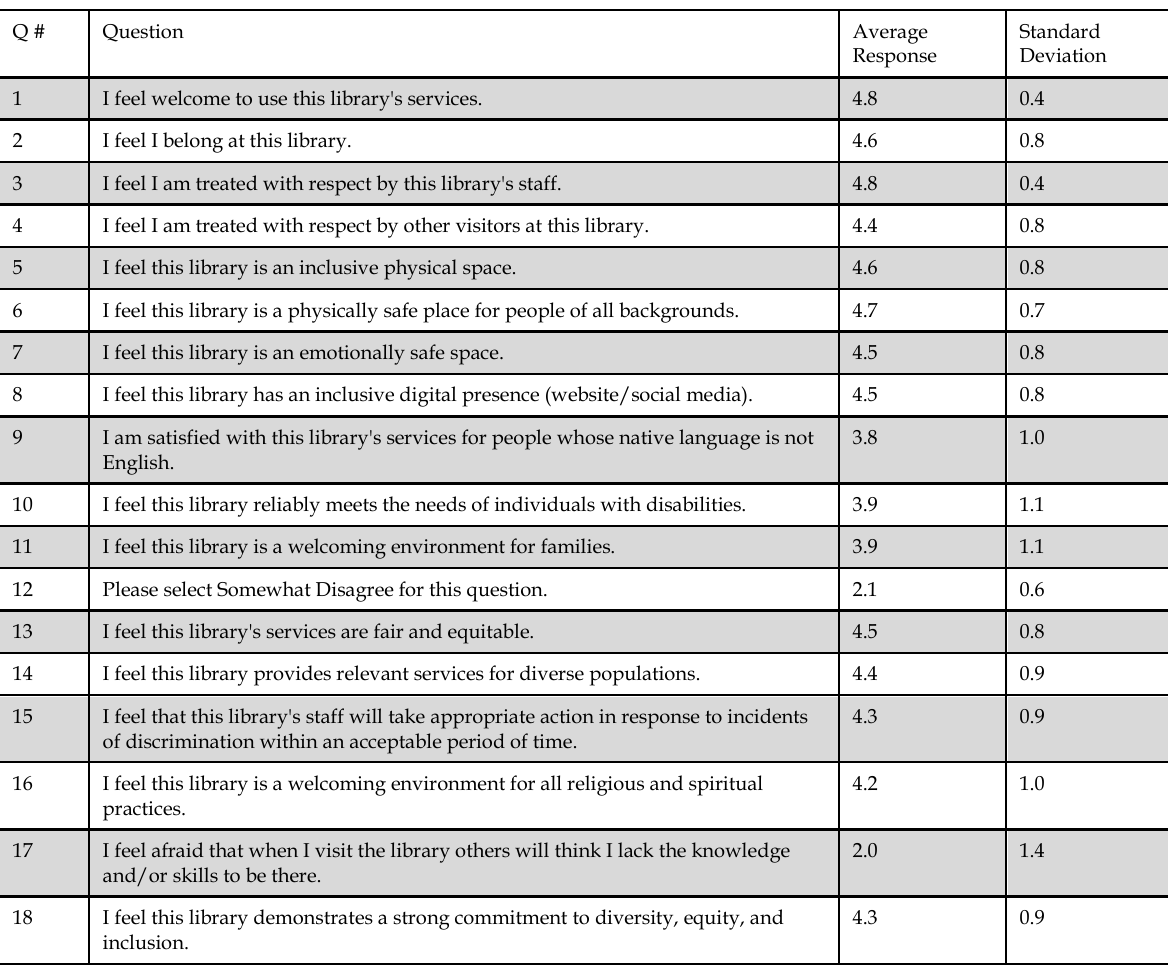
Table 1 Mean response for each Likert question. Response options were: 1=Strongly disagree, 2=Somewhat disagree, 3=Neither agree nor disagree, 4=Somewhat agree, 5=Agree. Question number 12 was the attention check question and question number 17 was negatively-worded, with a lower score indicating a positive